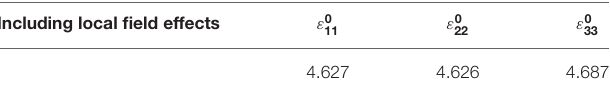
TABLE 3 | Calculated Born effective charge tensor of aluminum and nitrogen ions of aluminum nitride calculated by applying a homogenous electric field −→ E x y z eV/Å. 0.02 0.02 0.02 ˆ ˆ ˆ = + +